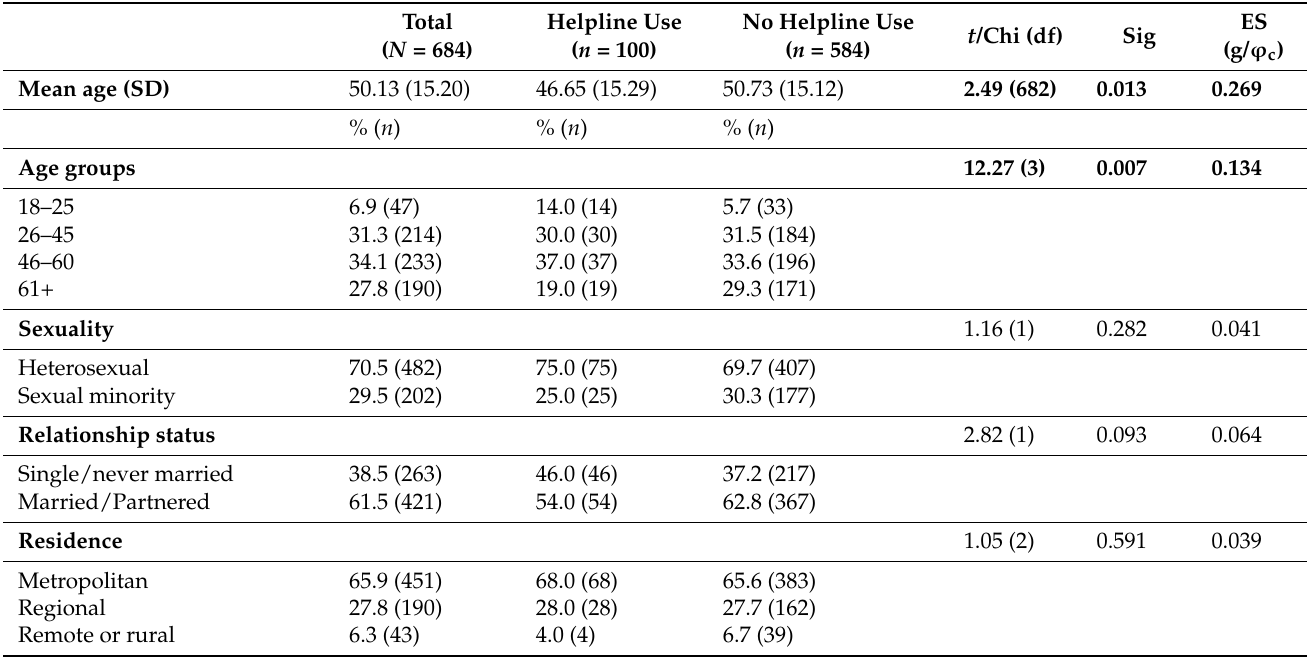
Table 1. Participant demographics and key variables by helpline